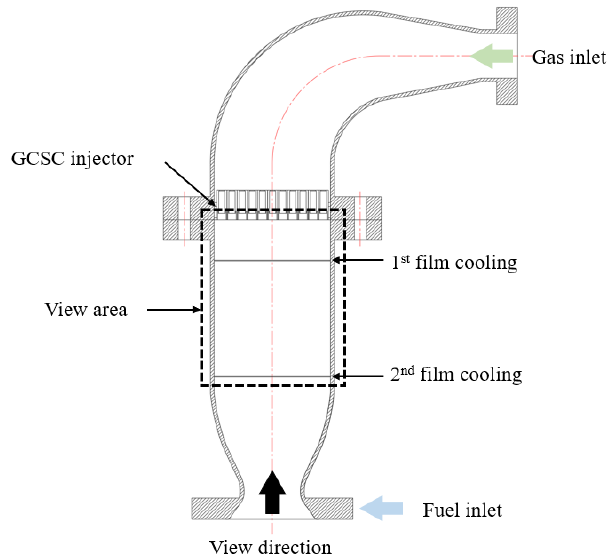
Figure 11. Combustion chamber cross-section and view direction.